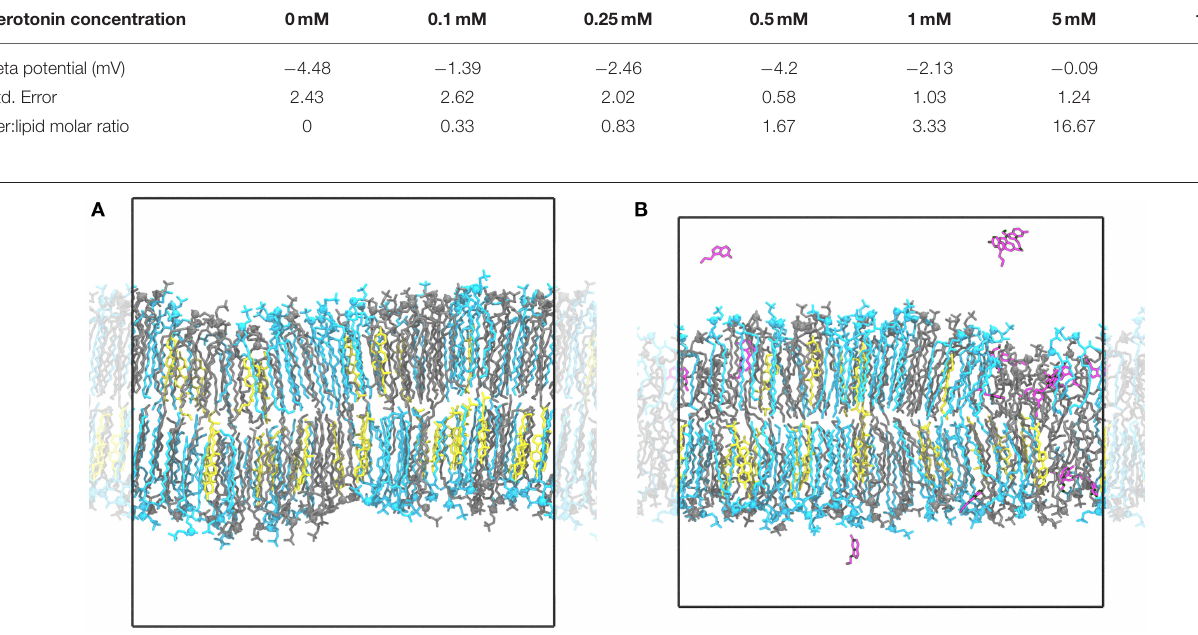
FIGURE 1 | Ordered and disordered membrane domains. Shown are snapshots of the L d / L o membrane (POPC:PSM:Chol at 4:4:2) at 294K without (A) and with serotonin (B) . In the absence of serotonin, the membrane is overall highly ordered with ≈ 60% of all lipids assigned to the ordered HMM state. In the presence of serotonin, larger disordered and diluted, serotonin-enriched lipid domains emerge suggesting a serotonin-induced phase transition. POPC lipids are depicted as blue sticks, PSM lipids in gray , cholesterol molecules in yellow , and serotonin molecules in magenta . Water molecules are omitted for clarity.